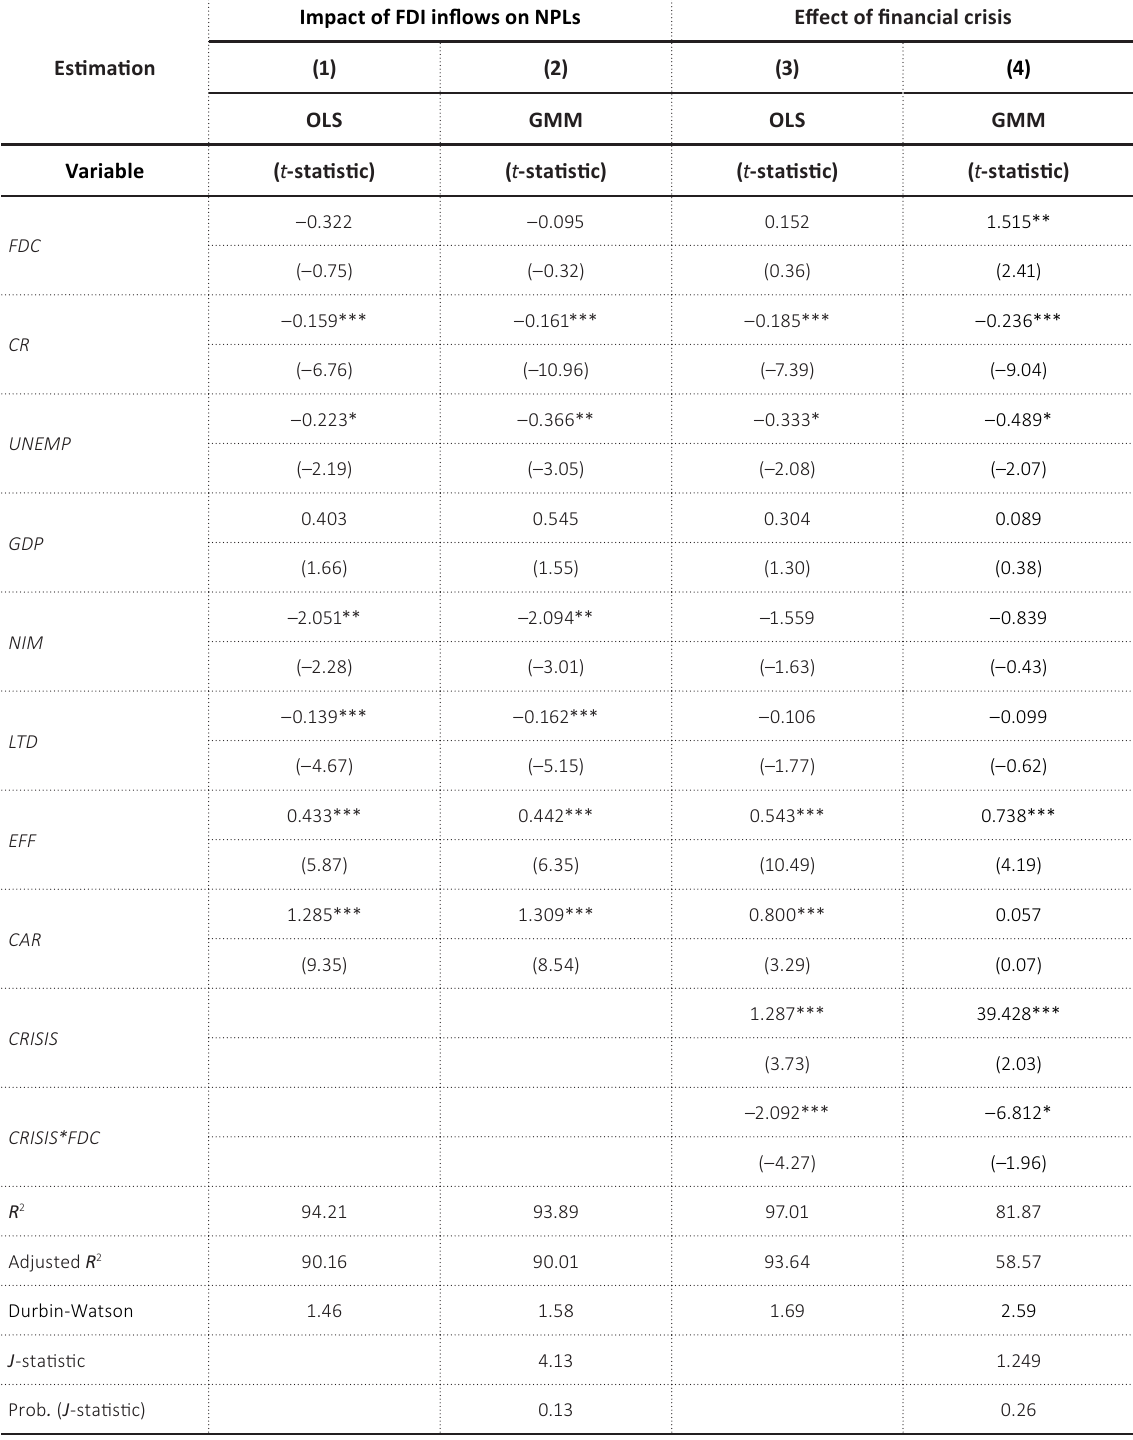
Table 8. Main results using the FDI per capita as the dependent variable